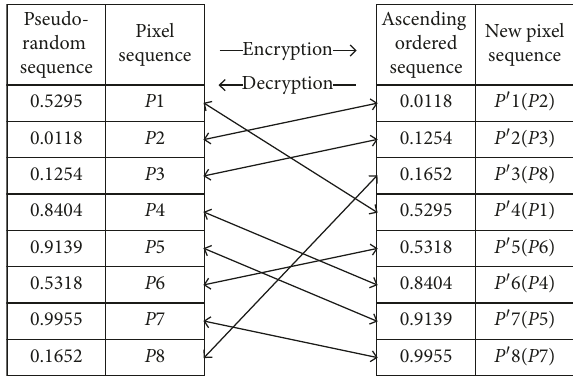
Figure 2: Examples of nucleotide operations under the first coding